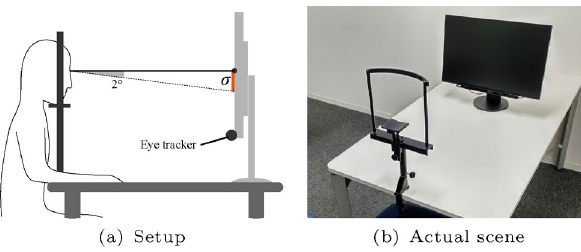
Fig. 2 Experimental setup. The angle of foveal vision was 2 ◦ ; σ is a Gaussian parameter used in generating a fixation